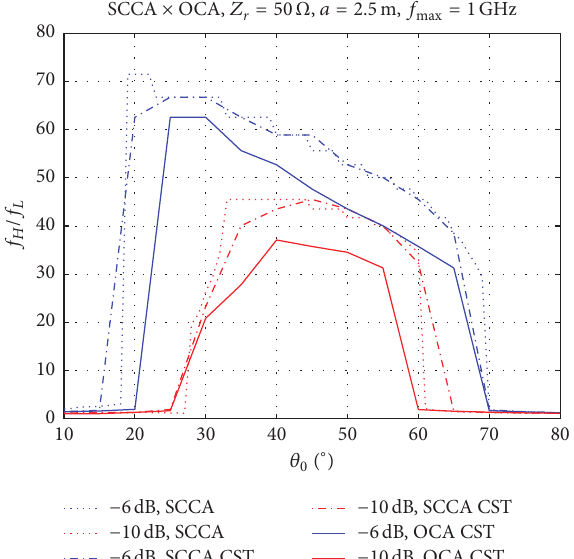
Figure 18: 𝑓 𝐻 /𝑓 𝐿 × 𝜃 0 chart for the theoretical SCCA and the CST simulated SCCA and OCA for 𝑍 𝑟 = 50 Ω .